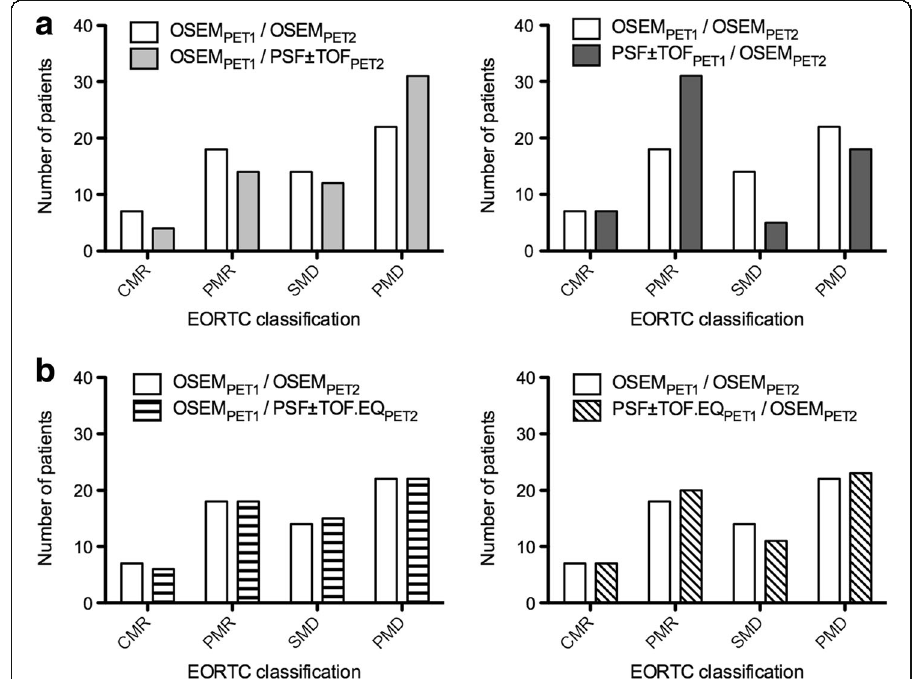
Fig. 3 Impact of reconstruction inconsistency on EORTC classification. EORCT classification is shown for the standard of reference (OSEM 1 /OSEM 2 ) and for other scenarios: reconstruction inconsistency between the baseline and post-treatment scans ( a ) and use of the EQ.PET methodology either for baseline or post- treatment scan ( b